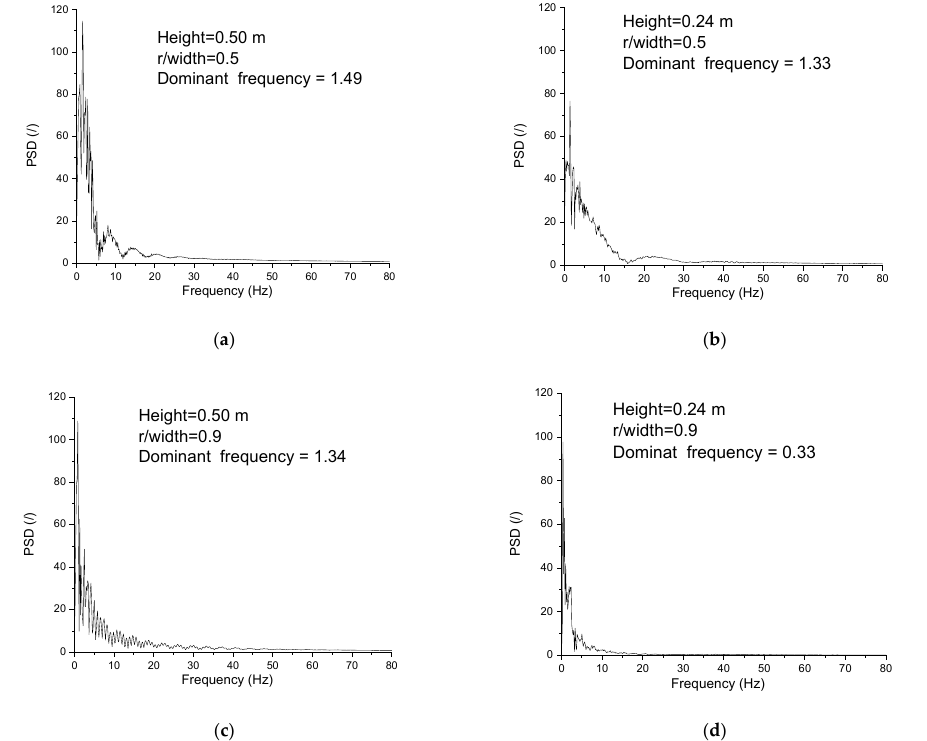
Figure 13. Power spectral density as a function of the porosity of EG particles at the height of 0.24 m and 0.5 m, r/Width = 0.5 and 0.9, ρ p = 800 kg/m 3 . ( a ) central distribution, 0.5 m; ( b ) central distribution, 0.24 m; ( c ) wall distribution, 0.5 m; ( d ) wall distribution, 0.24 m.